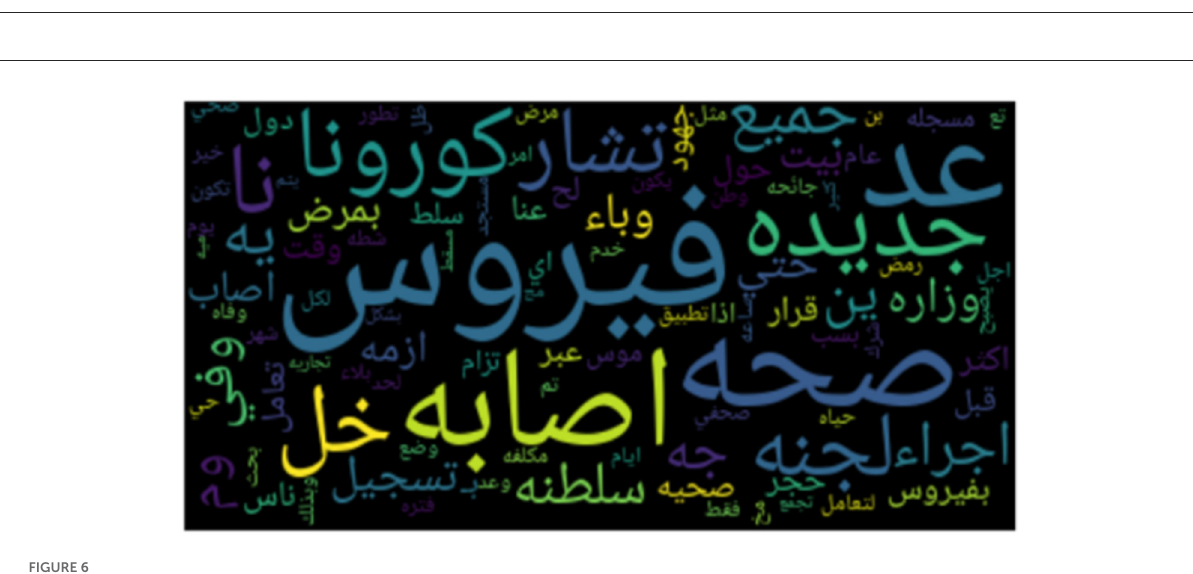
FIGURE6 Word cloud of tweets from